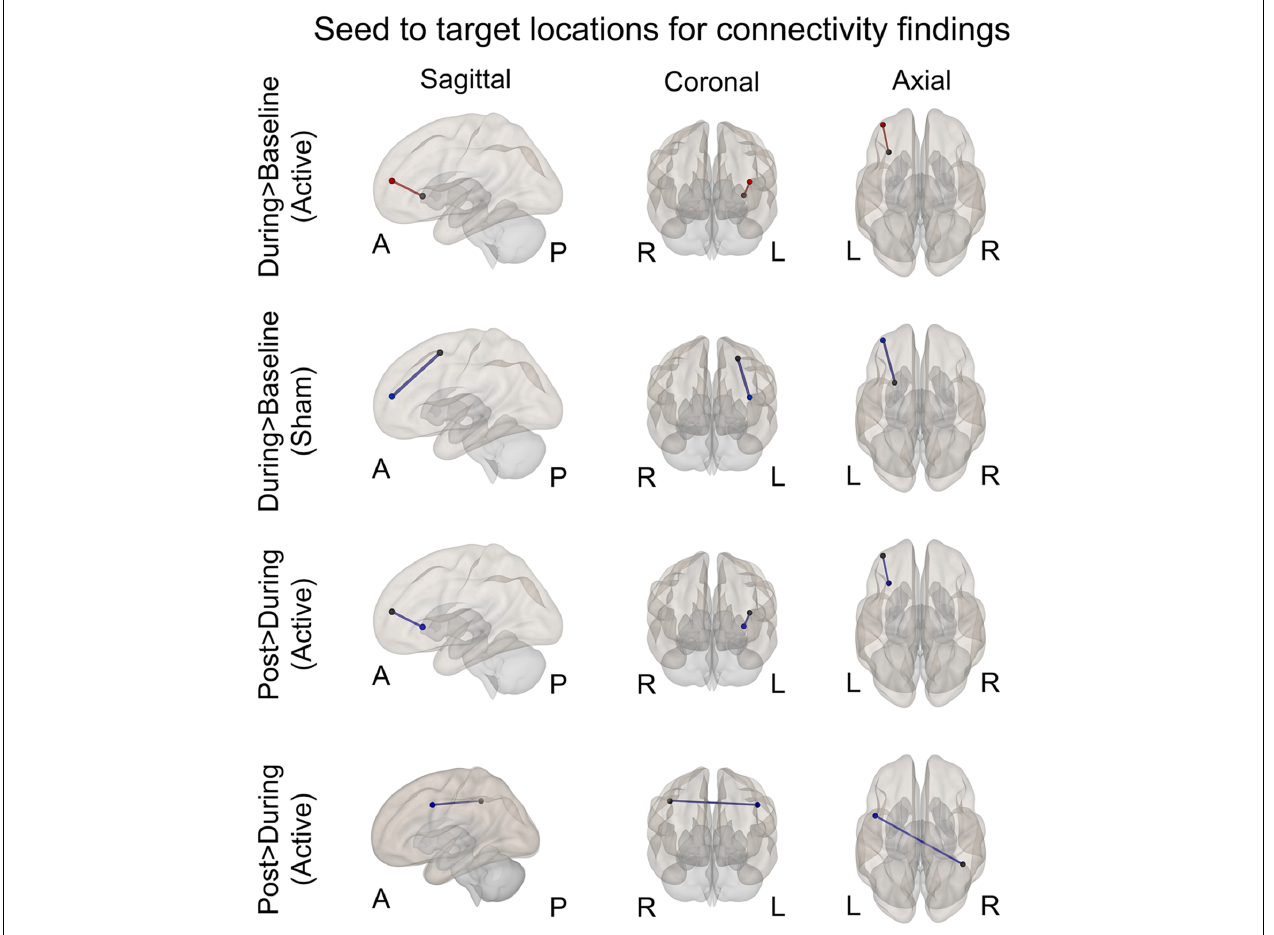
FIGURE 4 | Seed to target locations for significant connectivity findings. See Table 2 for seed to target location names. Nodes colored in black represent the seed location. Nodes color coded in red or blue indicate the target location. Red signifies significantly increased connectivity (FDR < 0.05). Blue signifies significantly decreased connectivity (FDR < 0.05). A, anterior; P, posterior; R, right; L, left.